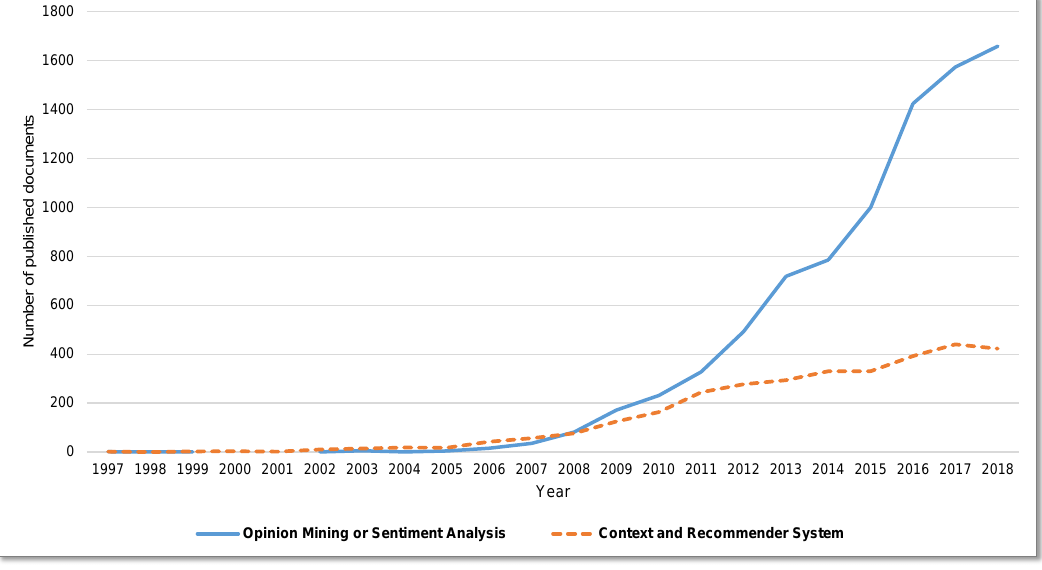
Figure 4. Evolution of research fields related to the systematic